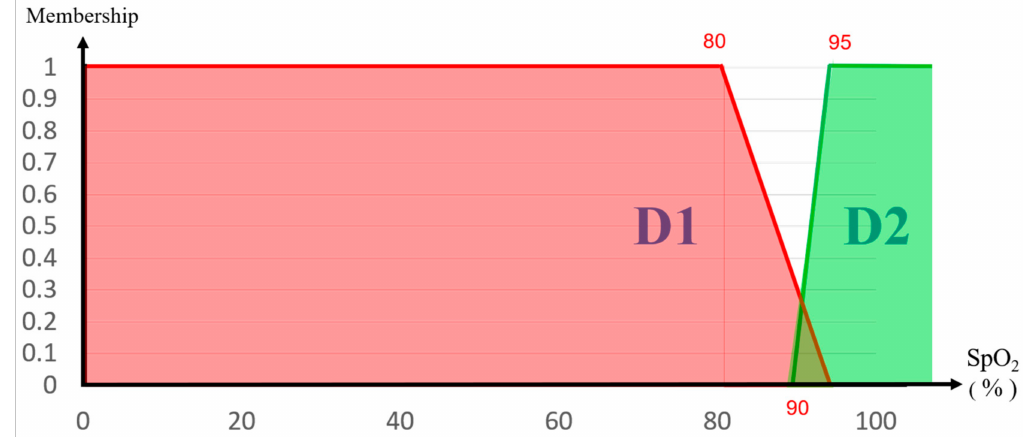
Figure 13. Set for blood oxygenation.